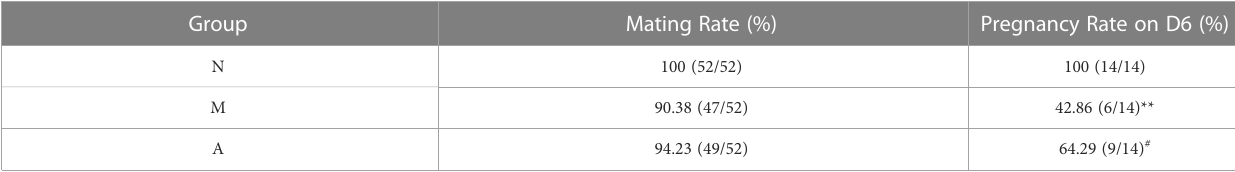
TABLE 2 Mating rate of rats in each group and pregnancy rate of D6 rats.